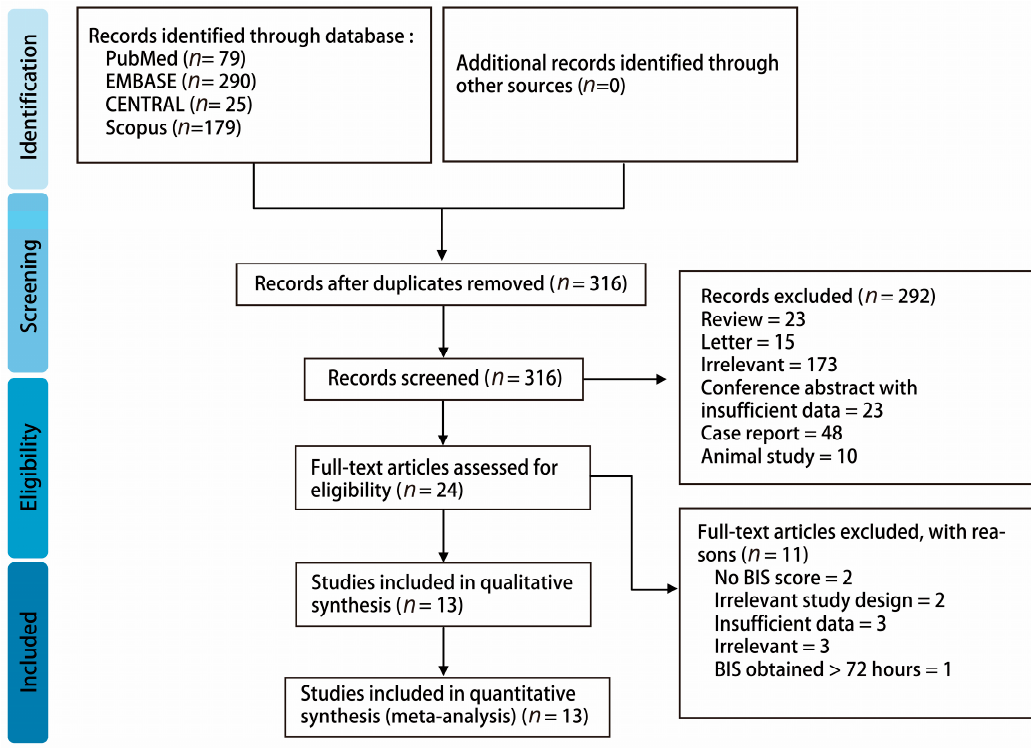
Figure 1. The detailed PRISMA flow diagram.